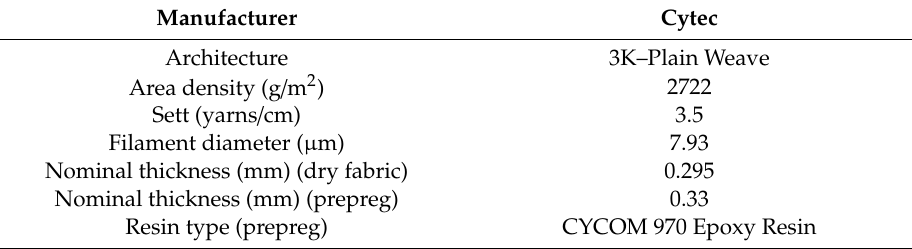
Figure 1. Materials used for the scanned samples ( a ) 3 K plain weave dry fabric; ( b ) Carbon / Epoxy prepreg with the same architecture as ( a ). The scanned region of interest (ROI) is shown in the red box. Table 1. Specifications of the selected dry and prepreg fabrics in this